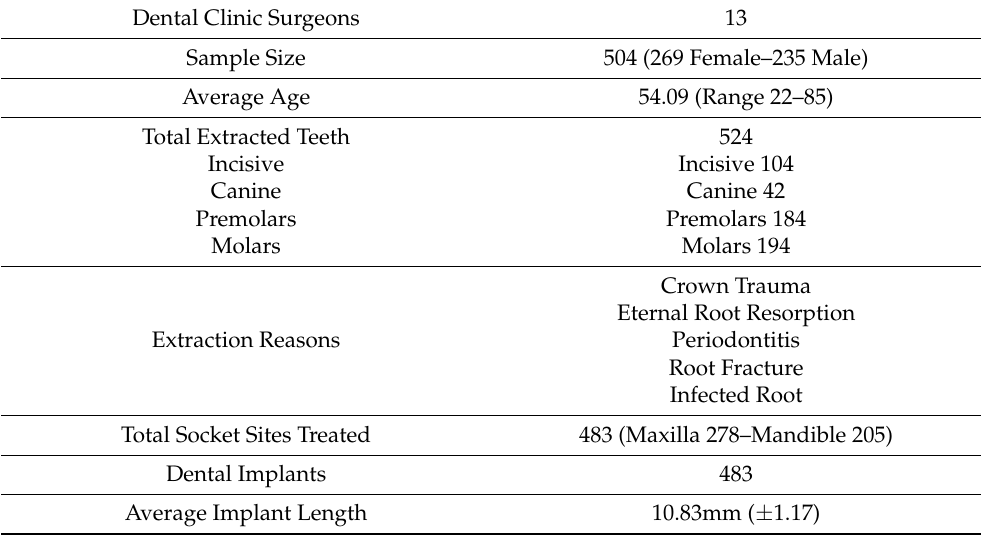
Table 1. Between April 2019 and December 2020, in 13 different dental clinics in Italy, Spain, Czech Republic and Singapore, 504 patients were treated with 483 dental implant